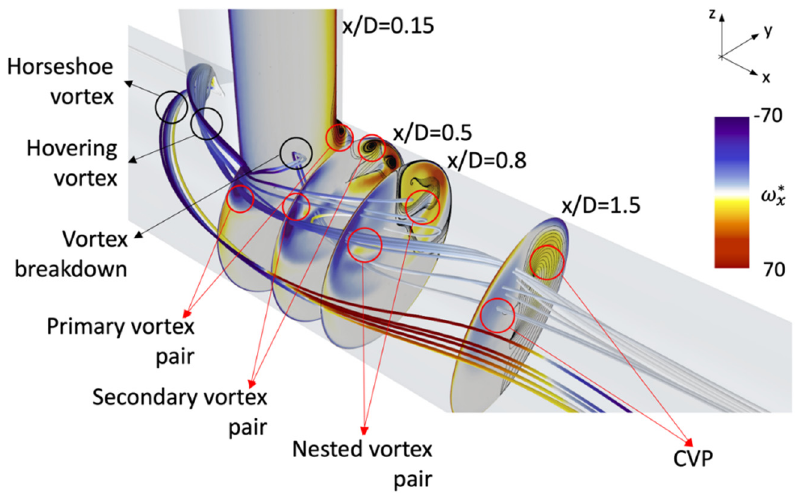
Figure 4. Distribution of regions of concentrated mean streamwise vorticity, ω ∗ x , on different cross- sections and mean velocity streamlines coloured by mean streamwise vorticity.